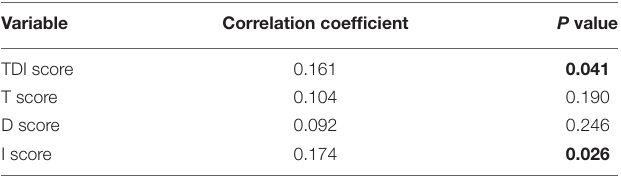
TABLE 6 | Multivariable linear regression analysis of clinical factors associated with MMSE score at year